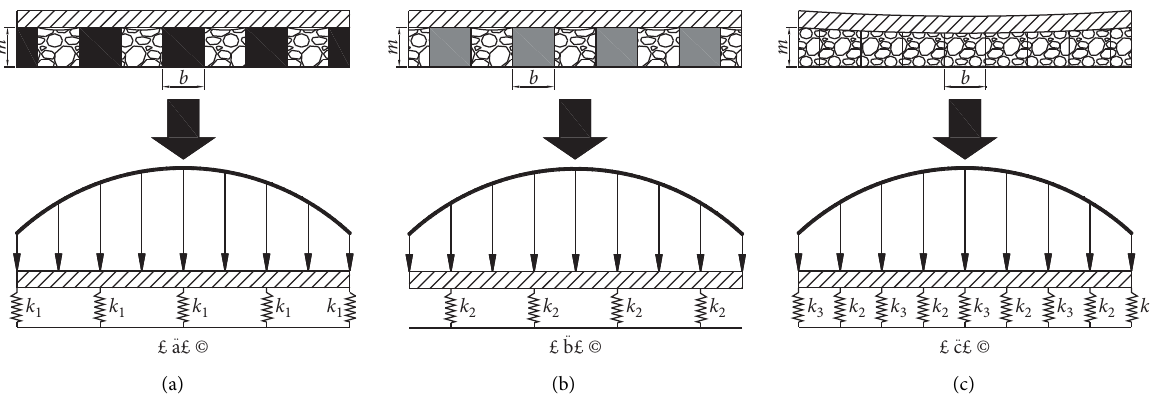
Figure 6: Mechanics model of RBM. (a) First stage. (b) Second stage. (c) Third stage.